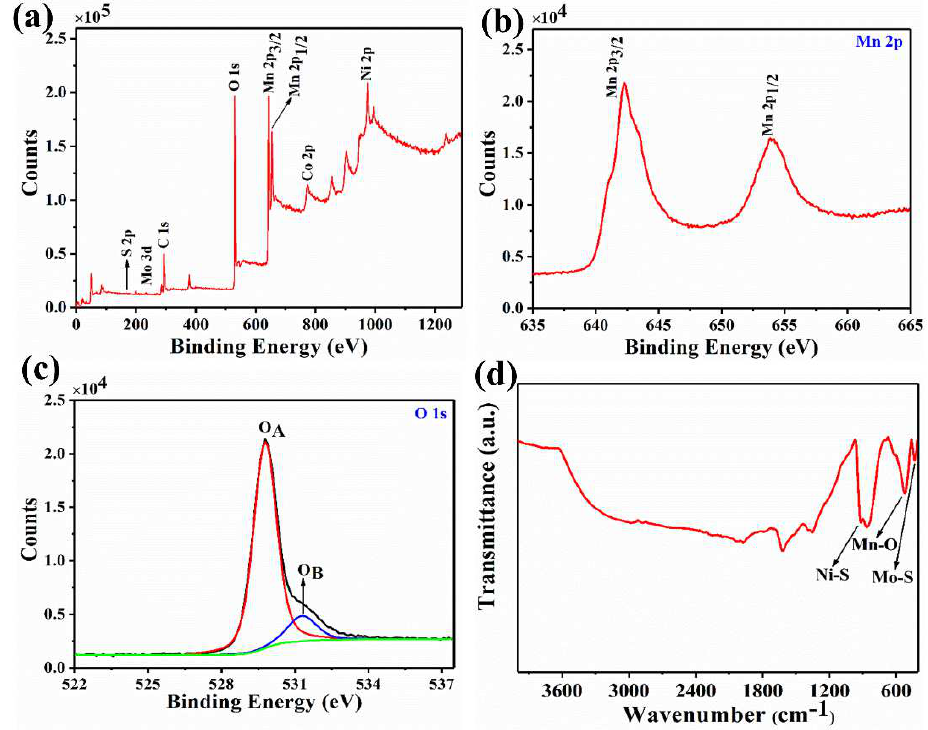
Figure 6. XPS survey spectrum of NCMSM: ( a ) survey spectrum; ( b ) Mn 2p; and ( c ) O 1s core-level spectra; ( d ) FTIR spectrum of NCMSM.